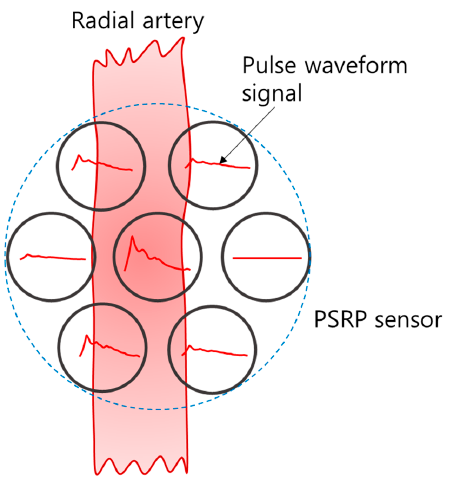
Figure 6. Schematic diagram for estimating blood vessel direction using PSRP.